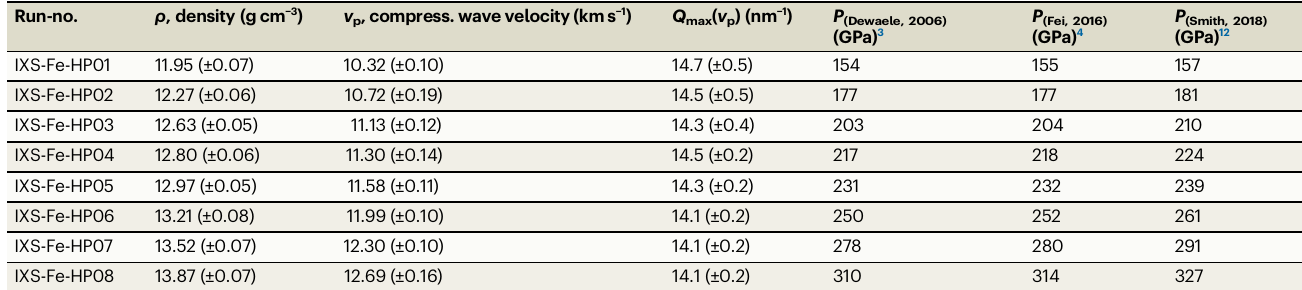
Table 1 | Experimental conditions and results